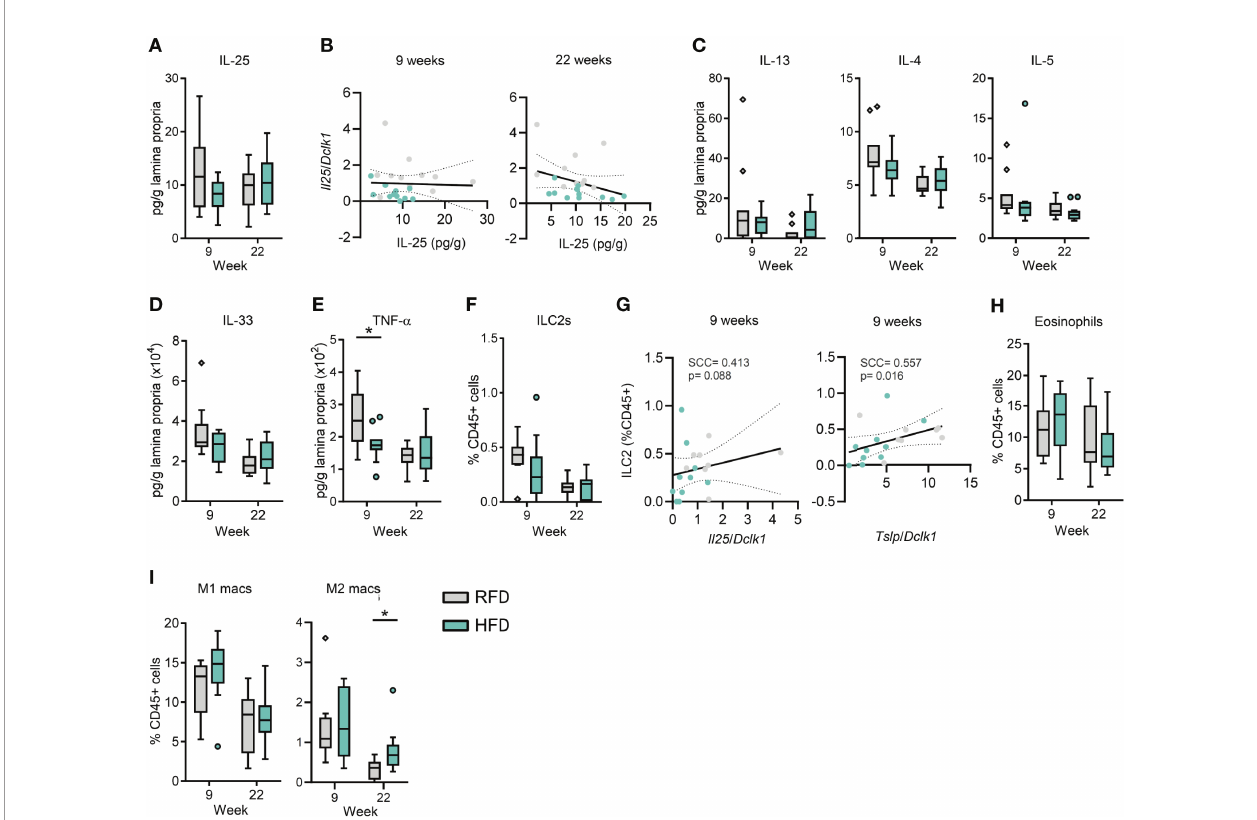
FIGURE 3 | The small intestinal immune system remains homeostatic during diet-induced obesity despite changes in tuft cell numbers and activity. (A) Concentration of IL-25 protein levels in ileal tissue. (B) Spearman rank based correlation analysis between expression levels of ( Il25 relative to Dclk1 ) in puri fi ed tuft cells and ileal IL-25 protein levels upon 9 weeks and 22 weeks of HFD or RFD. Protein concentrations of (C) IL-13, IL-4 and IL-5, (D) IL-33, and (E) TNF- a in ileal tissue. (F) ILC2 quanti fi cation (as % of total CD45+ cells) by fl ow cytometry of small intestinal lamina propria cells. (G) Spearman rank-based correlation analysis between proportions of ILC2s (as % of total CD45+ cells) and expression levels of Il25 and Tslp (both relative to Dclk1 ) in puri fi ed tuft cells after 9 weeks of HFD or RFD. Quanti fi cation of (H) eosinophils, (I) M1 and M2 type macrophages (as % of total CD45+ cells) by fl ow cytometry of small intestinal lamina propria cells. N=10-12 per group, derived from three repeated experiments. * p < 0.05 by Mann-Whitney U test. Graphs depict boxplots showing median (center line), 25th to 75th percentiles (inter-quartile range) (box limits), +/- 1.5 times IQR (Tukey ’ s whiskers) and outliers. Spearman ’ s rank correlation was used for correlation analyses with p -values < 0.05 considered statistically signi fi cant. SCC, Spearman correlation coef fi cient; RFD, reference fat diet; HFD, high fat